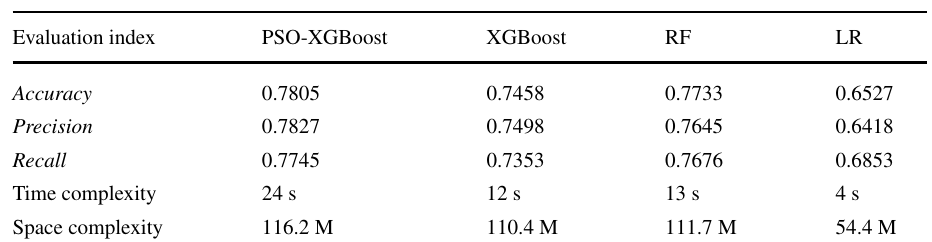
Table 15 Comparison of evaluation indexes of models Evaluation